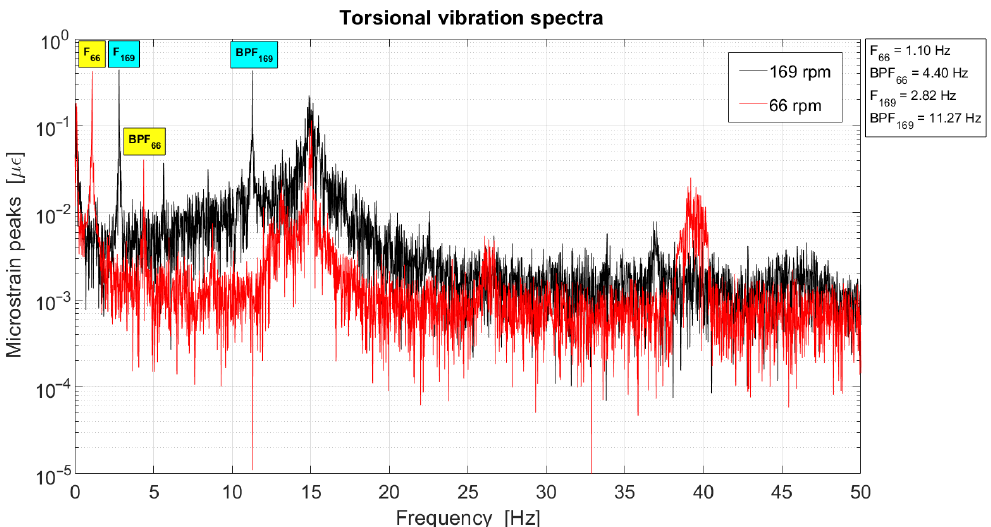
Figure 10. Torsional vibration spectra at 66 rpm and 169